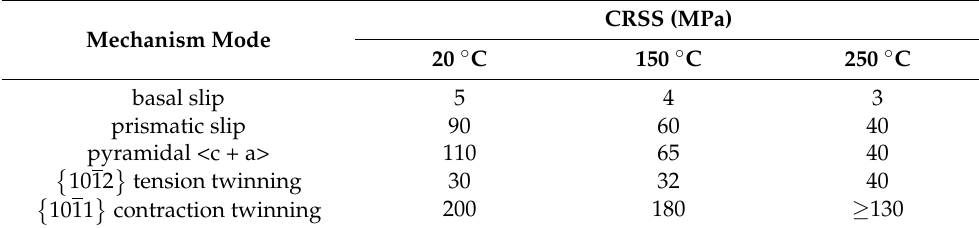
Table 2. The CRSS of different microstructure deformation mechanism